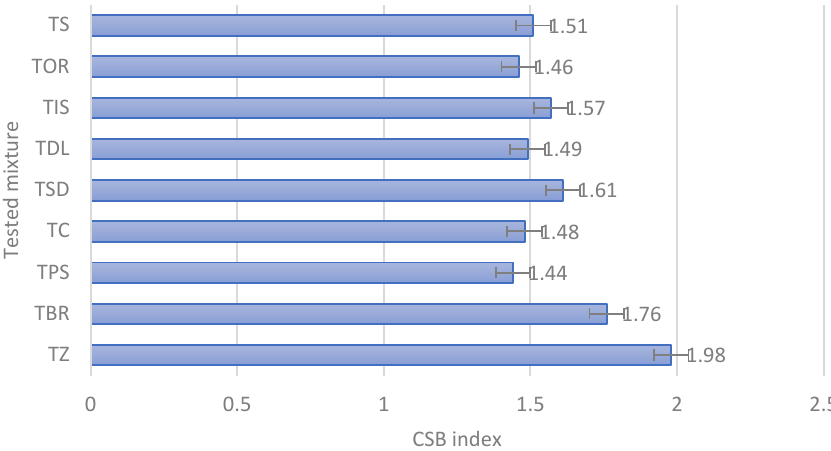
Figure 9. Drying linear shrinkage and Bending strength of the dried samples.